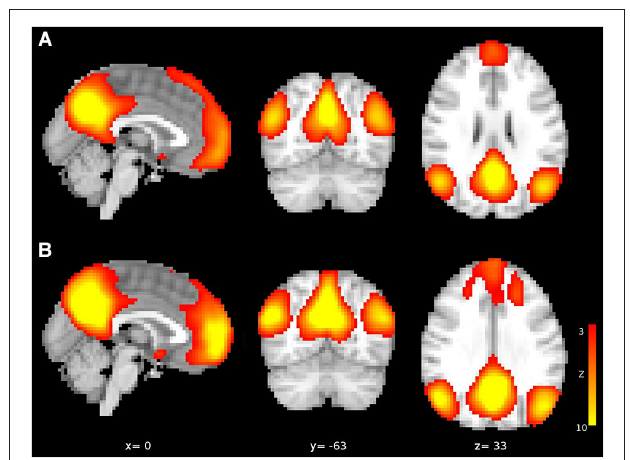
FIGURE 1 | Independent components corresponding to DMN from (A) the first sample and (B) the second sample . Both components are arbitrarily thresholded at z = 3 and red-yellow scale indicates greater connectivity to DMN.